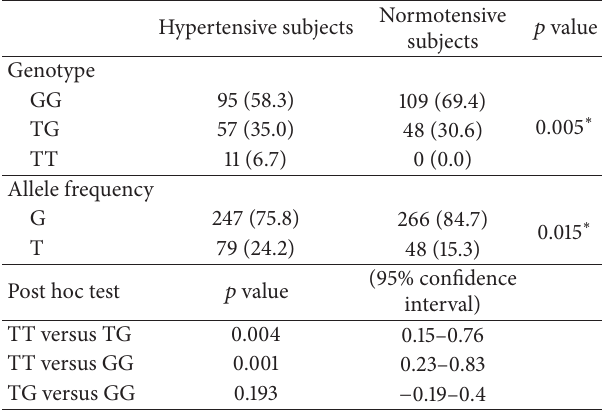
Table 2: Genotype and allelic frequency distribution between hypertensive and normotensive